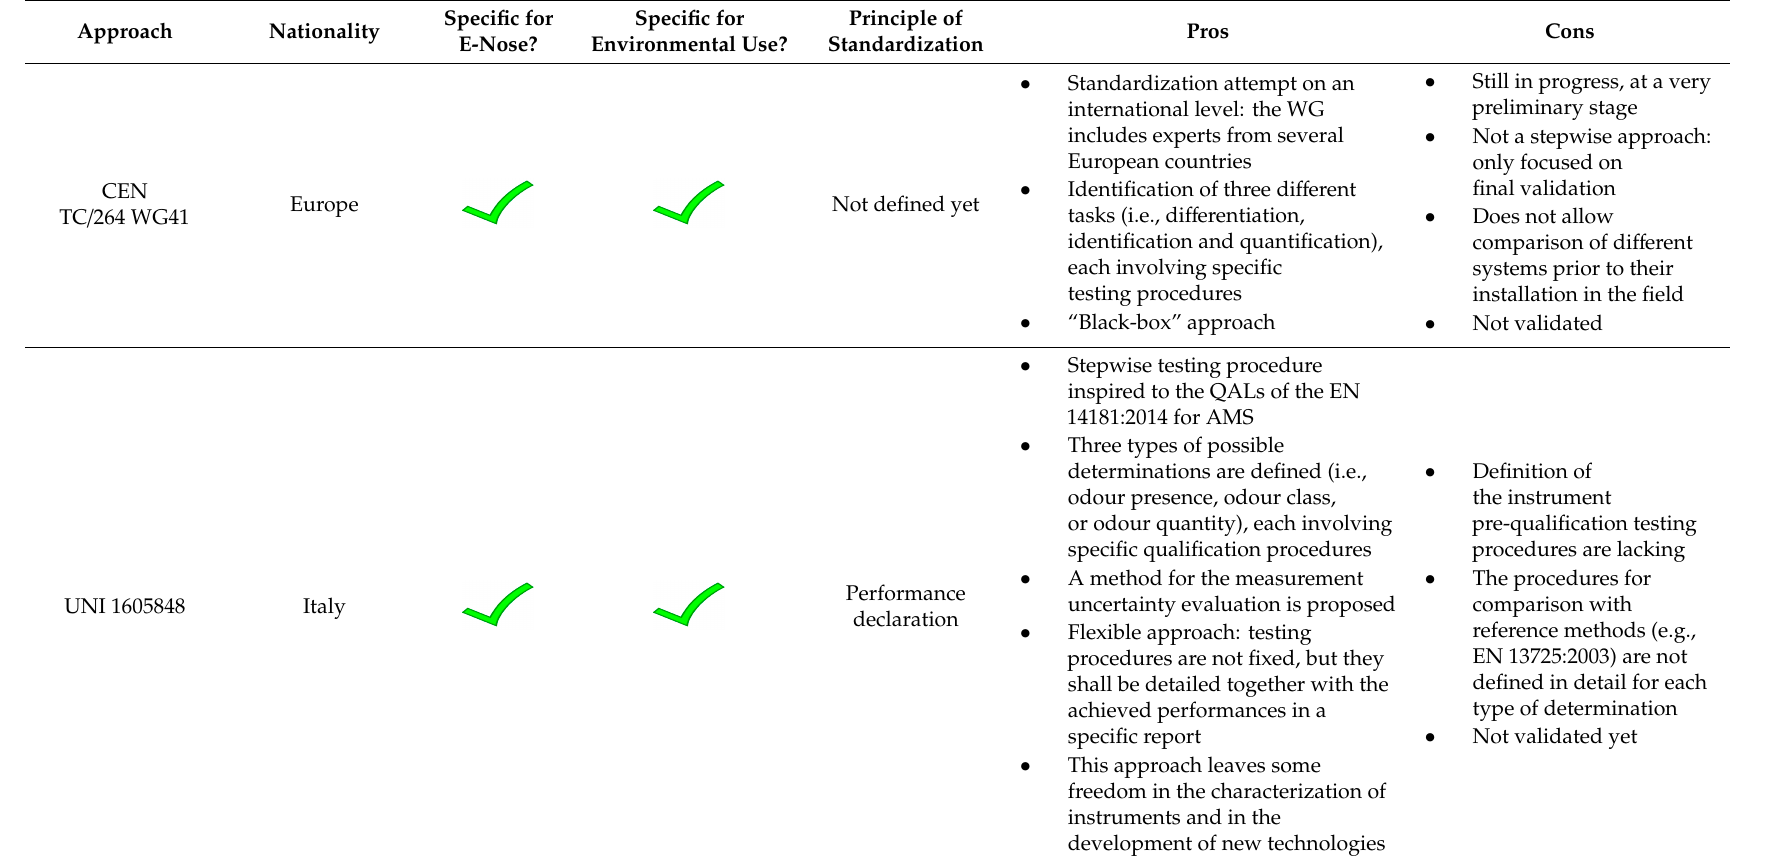
Table 1. Cont. Table 1. Schematization of the existing approaches that can be applied for e-nose qualification and standardization in environmental odour monitoring applications. Approach